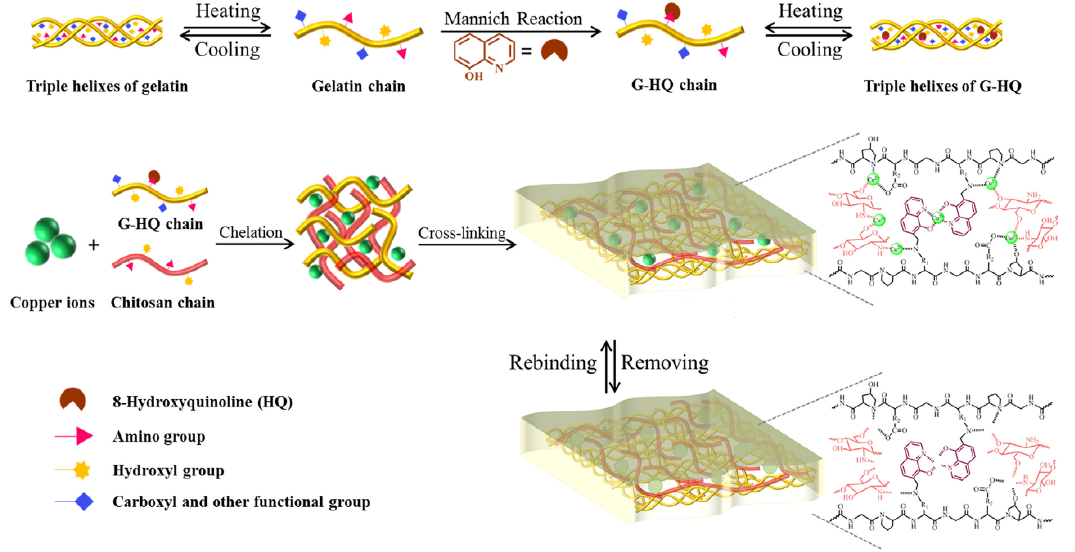
Figure 4. Description of preparation process for gelatin-8-hydroxyquinoline-chitosan (G-HQ-CS) ion imprinted polymers (IIPs). Reproduced from the work in [52] with permission from Elsevier.